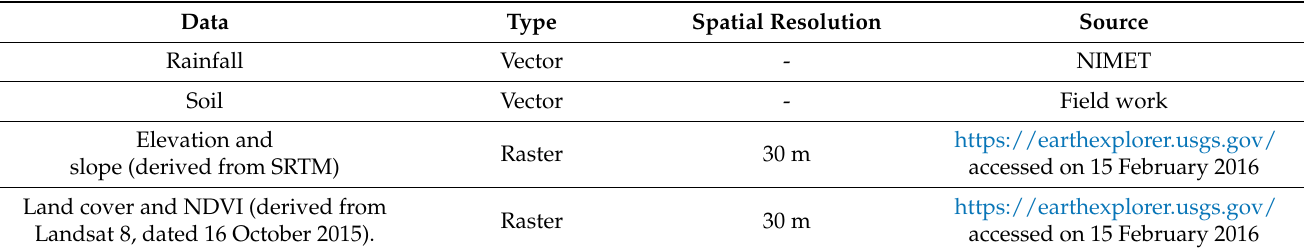
Figure 4. Illustration of workflow. Table 1. Data